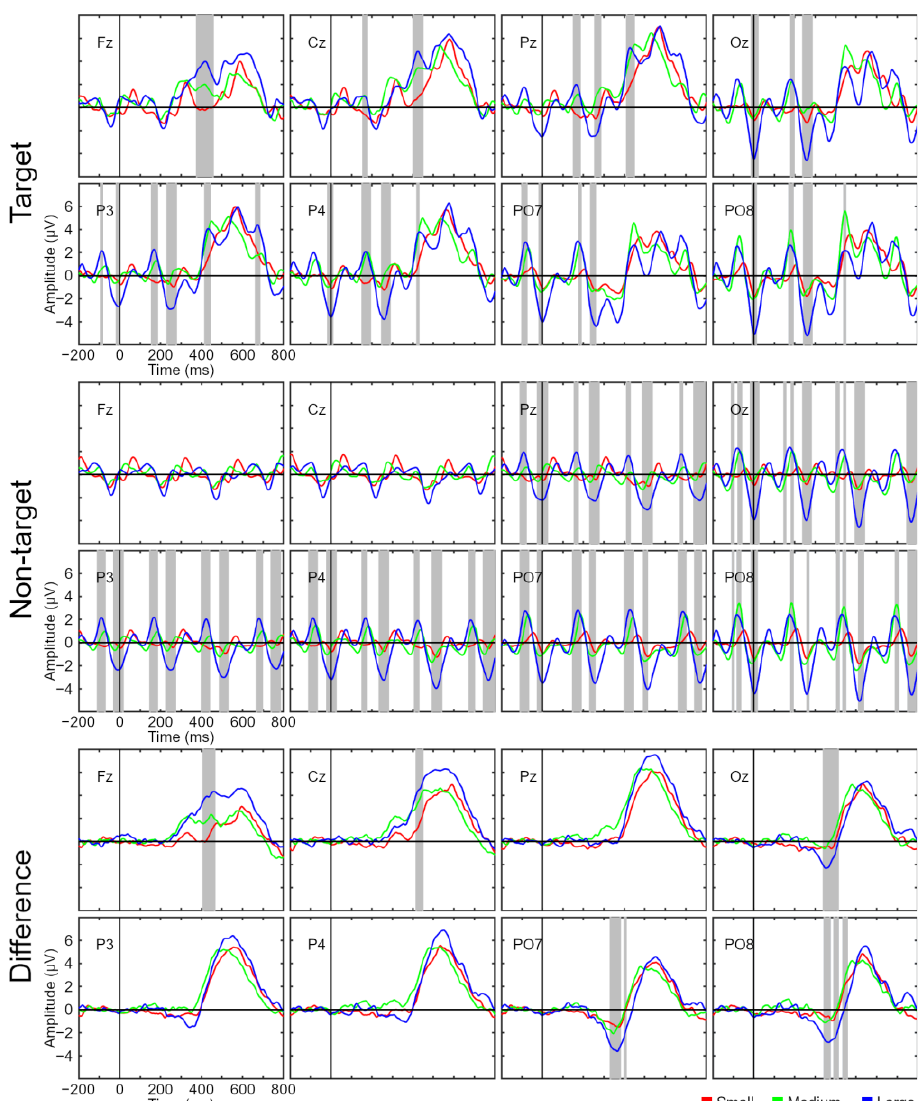
Figure 5. Grand average event-related potential waveforms for the target and non-target stimuli signals and the amplitude differences between them for all channels used (Fz, Cz, Pz, Oz, P3, P4, PO7, and PO8) and for the three conditions (small, medium, and large). Significant intervals are denoted with a gray background on the time axis. The Holm correction method was applied.